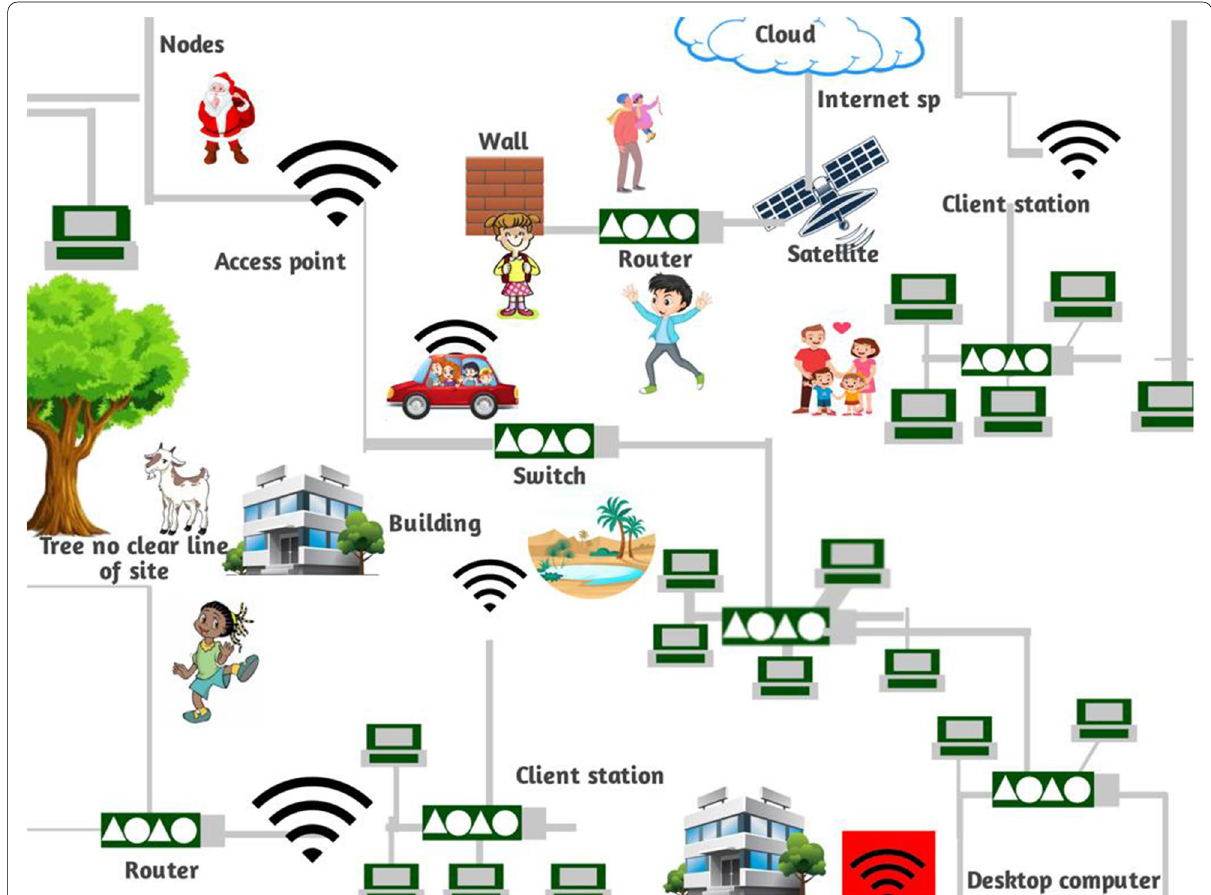
Fig. 1 Tourism Cloud Management System (TCMS)